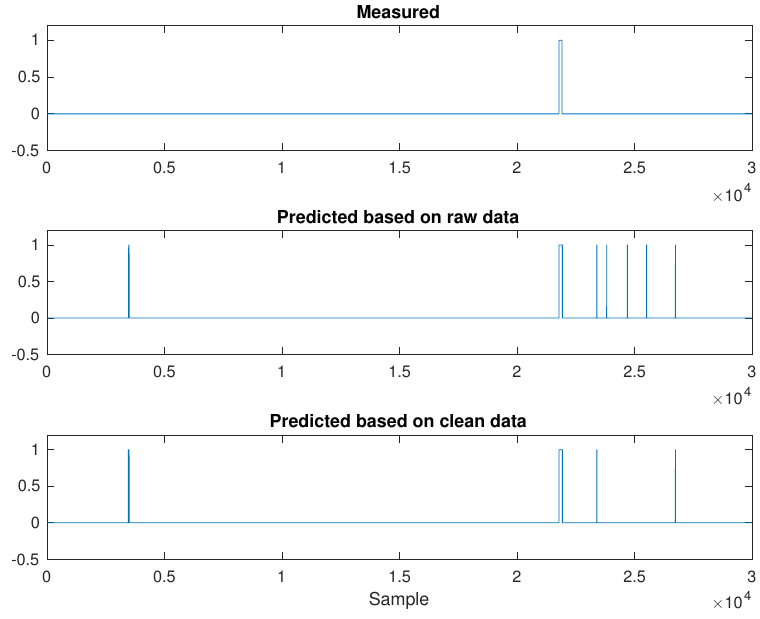
Figure 11. Flare 2: PLS-DA analysis based on raw and clean